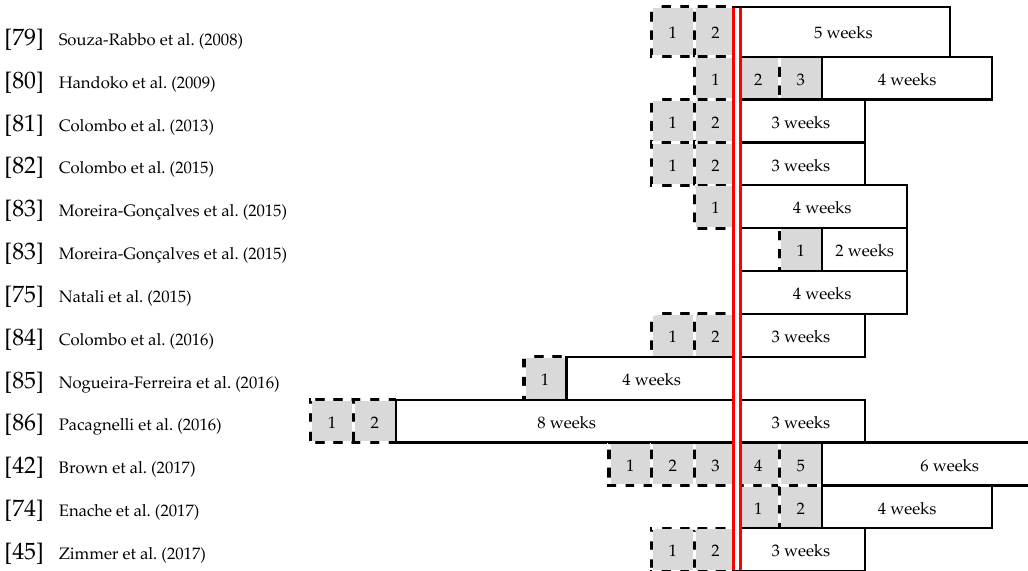
Figure 3. Scheme of exercise interventions in animal studies. The experimental PAH was induced by a monocrotaline (MCT) injection in all included animal studies. The MCT injections (red line) and training programs were scheduled for different time points to assess various effects of exercise training (ET). In all studies [42,45,74,75,79,80,81,82,83,84,85,86], an adaptation period, highlighted in grey, was provided for 1–5 weeks to familiarize the rats with the treadmill running and adjust a similar baseline level. The periods of the training interventions are marked in white boxes (modified according to Moreira-Gonçalves et al. [87] ).